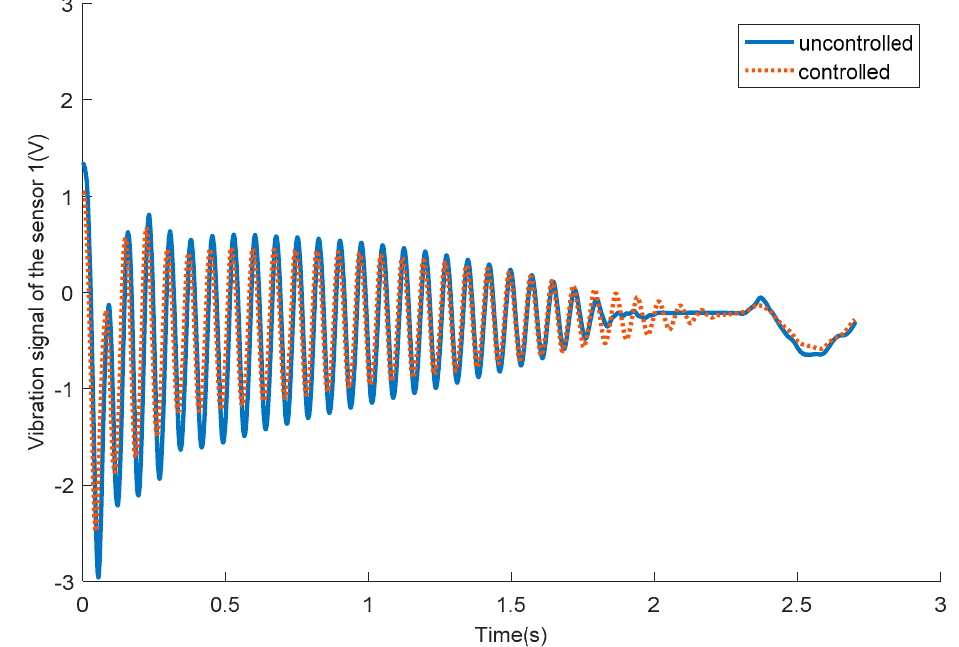
Figure 16. The vibration signals of passive flexible link 1 for the uncontrolled and controlled systems.